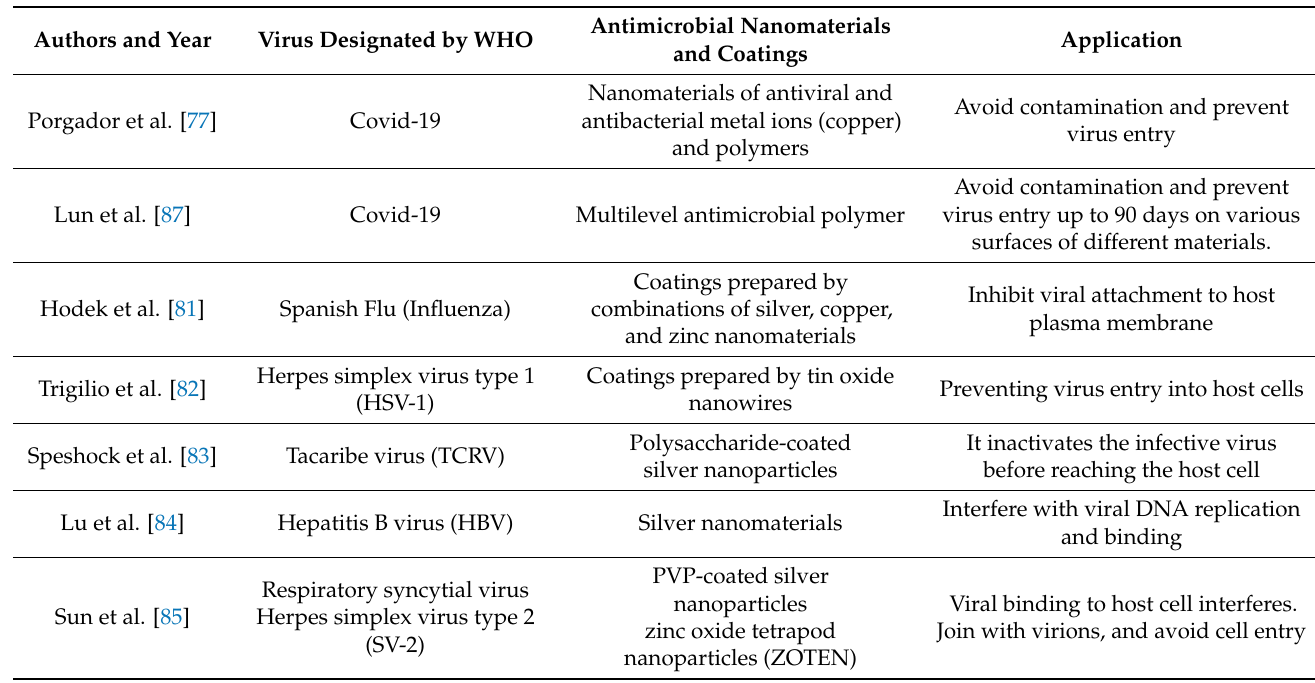
Table 4. Virucidal effects of antimicrobial nanomaterials and